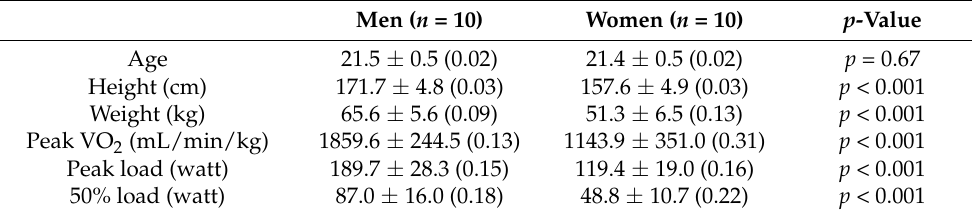
Figure 1. A schematic representation of the study procedures. Table 1. Participants’ characteristics.